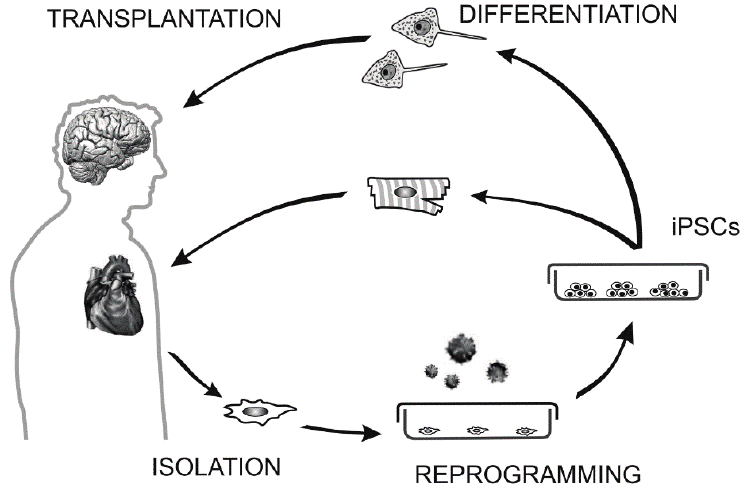
Figure 1. Generation of iPSCs and their use in cell